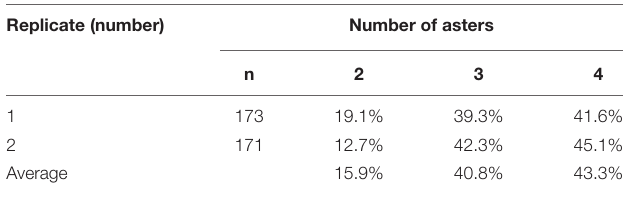
TABLE 2 | Percentage of fertilized C. farreri eggs with a specific number of asters in meiosis II following inhibition of PB1 with CB. Replicate (number) Number of